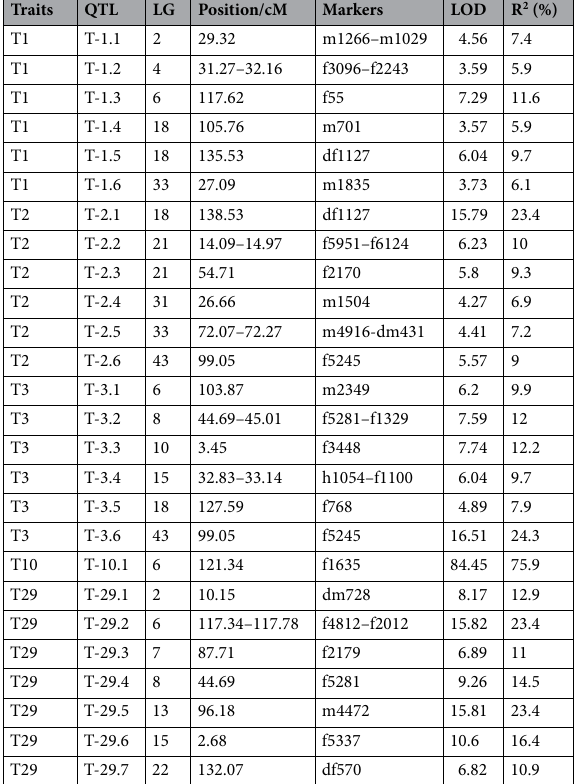
Table 4. QTLs for 5 representative traits. T1 overall length, T2 body weight, T3 body length, T10 sex, T29 antiviral properties.